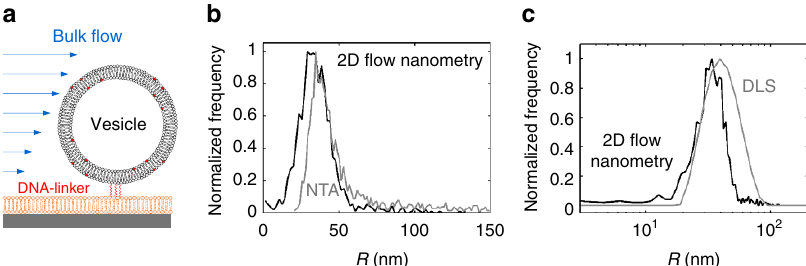
Figure 4 | 2D flow nanometry applied to SUVs. The SUVs (created by extrusion as described in the ‘Methods’ section) were linked by cholesterol- equipped 13nm DNA-tethers to the SLB ( a ). Comparison of vesicle size distributions obtained by NTA ( b , grey curve), DLS ( c , grey curve; intensity distribution) and using 2D flow nanometry ( b , c , black curve).